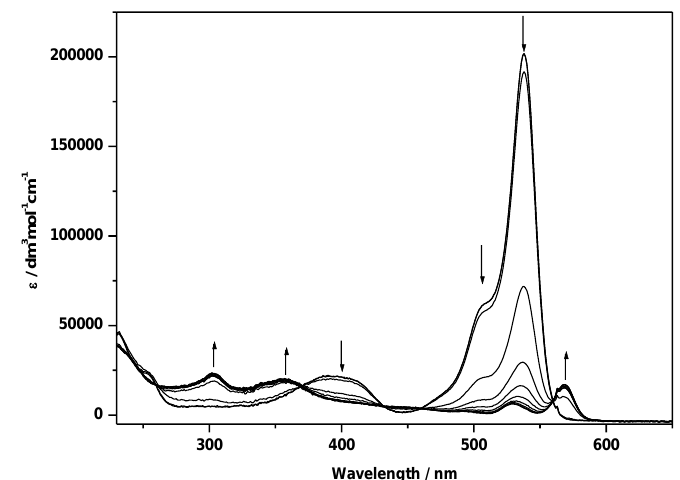
Cl with [ n Bu N][BF ] as electrolyte at 243 K. 2 2 4 4